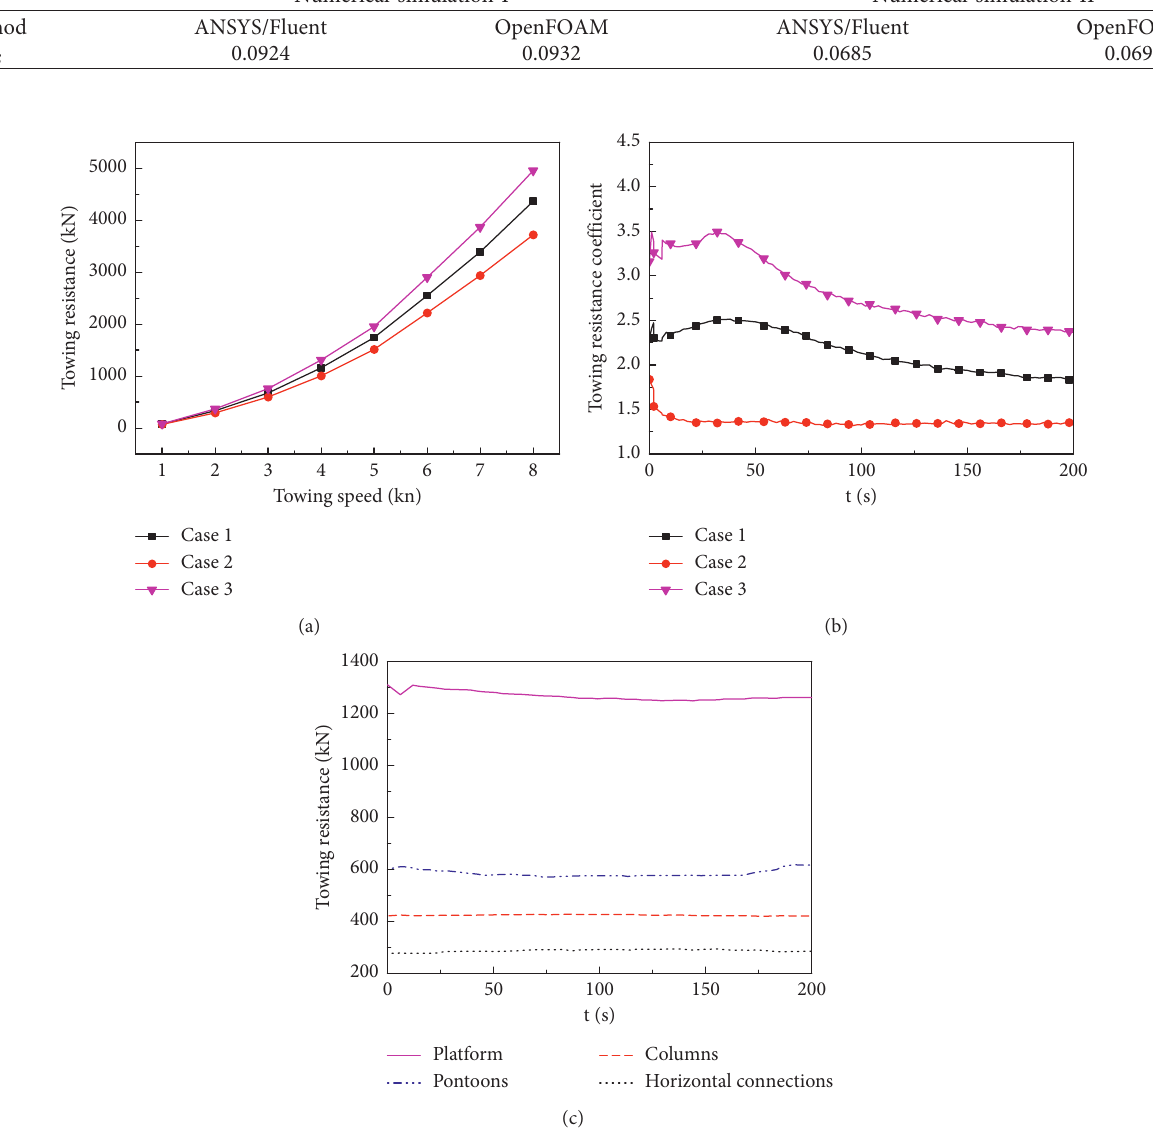
Figure 12: (a) The towing resistance of the platform at different towing speed, (b) the towing resistance coefficient of the pontoons in Cases 1 to 3 at the towing speed of 4kN, and (c) the towing resistance of Case 3 at the towing speed of